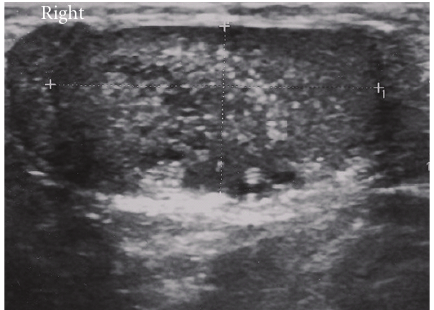
Figure 1: Scrotal ultrasound showing multiple small cystic lesions which comprise about 90% of the right testicular volume and are compressing the normal parenchyma to the